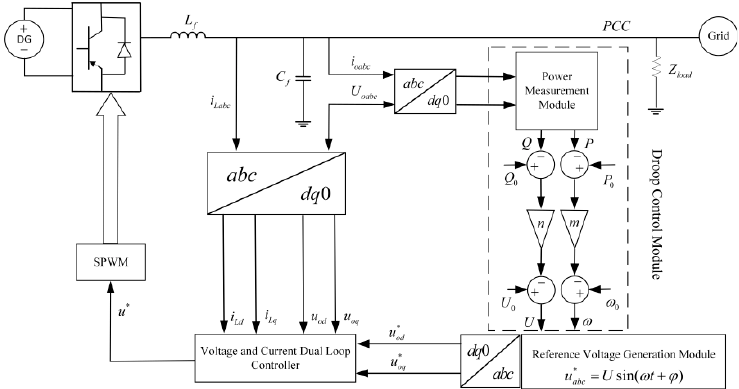
Figure 14. Block diagram of the droop controller.